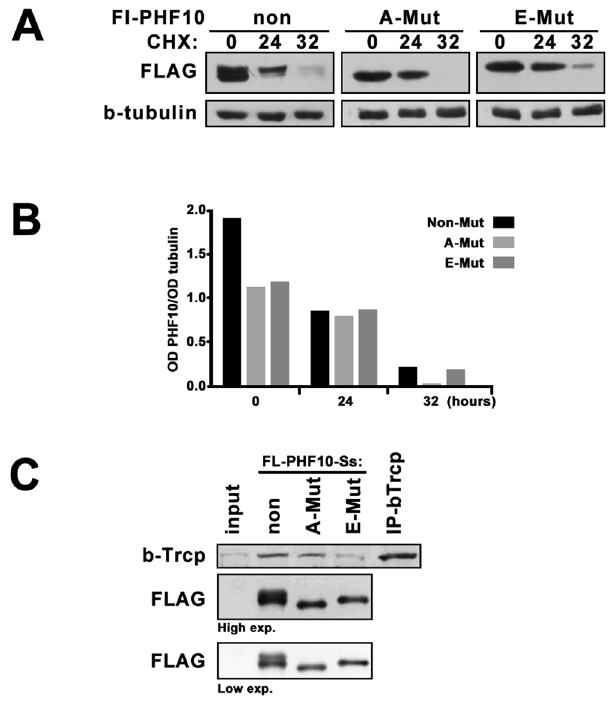
Figure 6. Comparing of the wild-type and mutated PHF10-Ss isoforms. ( A ) HEK293 cells transfected with FLAG-tagged PHF10-Ss, A-mutant or E-mutant were treated with CHX (20 mg/ml) for indicated time. Extracts were analyzed by Western blot, β -tubulin was used as loading control. E-mutant degraded slower than A-mutant similar to the X-phosphorylated (upper band) and non-phosphorylated (lower band) forms of wild-type PHF10-Ss. ( B ) The intensity of bands on Western blot was quantified by densitometry as described in Methods section. ( C ) HEK293 cells were transfected by FLAG-tagged PHF10-Ss, A-mutant or E-mutant isoform and PHF10 forms were precipitated from the extract of transfected cells on FLAG-agarose. Western blot was stained with antibodies against β -TrCP or FLAG. The wild-type PHF10-Ss and A-mutant co-precipitated β -TrCP stronger than E-mutant. Precipitation with anti- β -TrCP antibodies was used as positive control. Note that the level of precipitated FLAG-PHF10 in all lanes was equal (the wild type PHF10 isoform migrates with two bands, the upper one corresponds to phosphorylated form and thus does not interact with β -TrCP). The images in Fig. 6(A and C) are